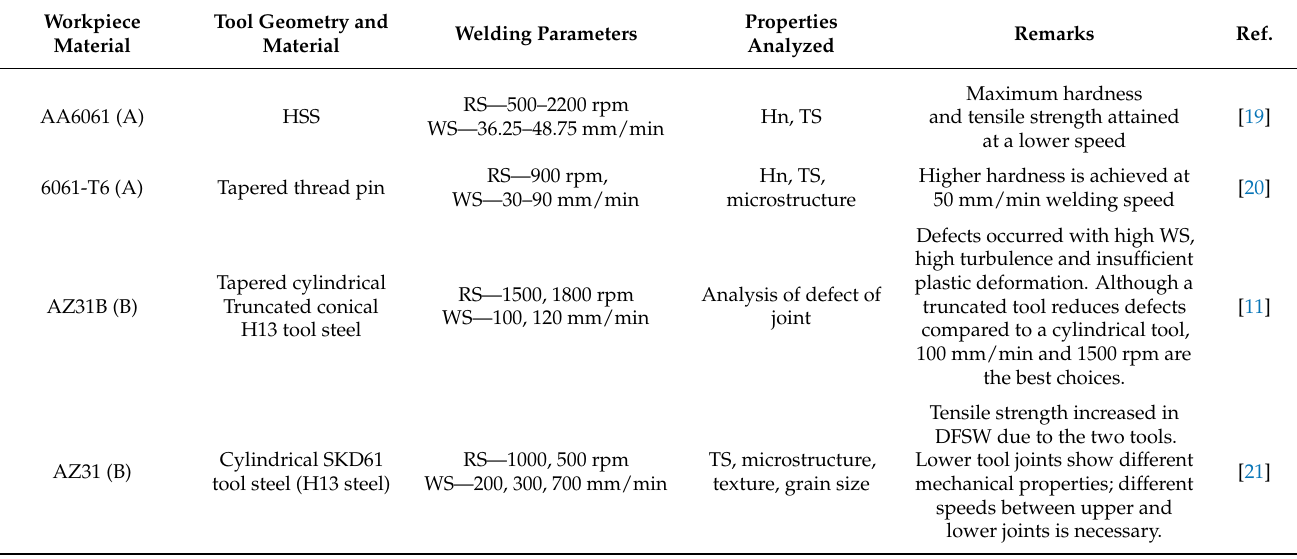
Table 1. FSW of AA6061, AZ31B, and